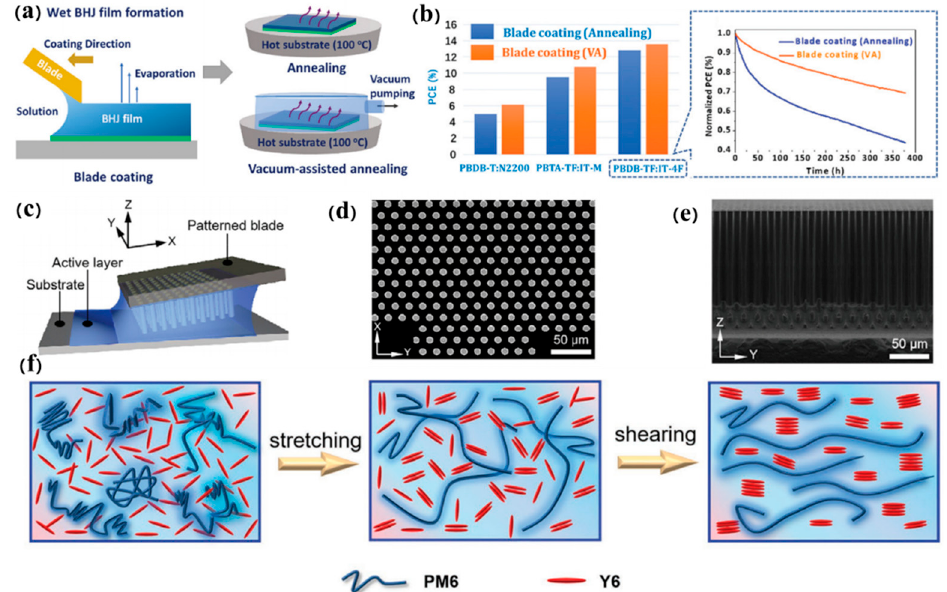
Figure 6. ( a ) Schematic illustration of blade-coated OSCs and vacuum-assisted annealing method. ( b ) PCE of various non-fullerene systems via different post-treatment methods. Adapted with permission from Ref. [97]. Copyright 2019 The Royal Society of Chemistry. ( c ) Schematic illustration of patterned blade coating. ( d ) Typical scanning electron microscopy (SEM) image of the circular patterned coating blade. ( e ) Cross-sectional SEM image of the circular patterned coating blade. ( f ) Schematic diagram of conformational changes in polymer and non-fullerene small molecules in stretching and shearing field Adapted with permission from Ref. [56]. Copyright 2021 Wiley − VCH.